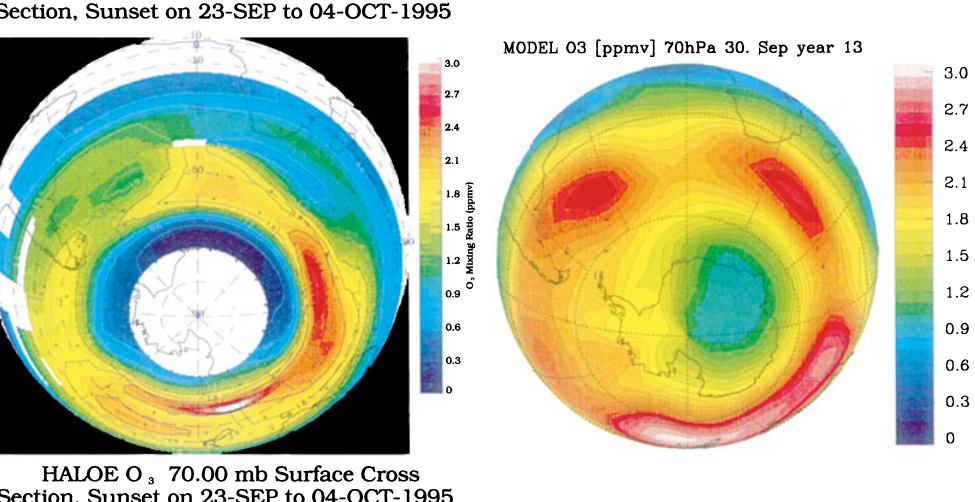
Fig. 13. Left-hand side : southern-hemisphere HALOE ozone measurements (in ppmv) at 70 hPa, representing the time-period between 23 September and 4 October 1995. Data points (+) progress from low to high latitudes. Right-hand side : corresponding ozone chart of ECHAM3/ CHEM results for 30 September of model